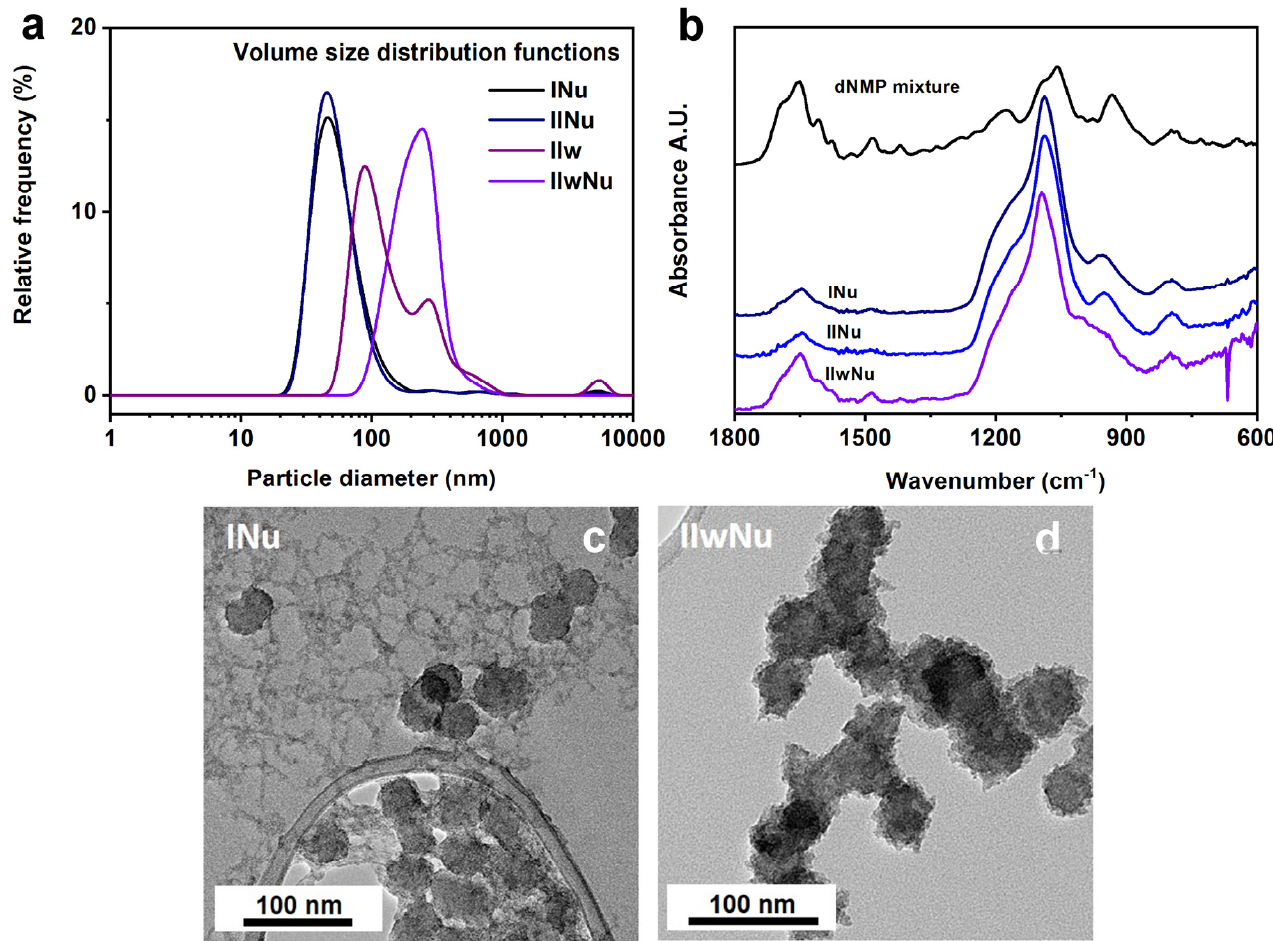
Figure 6. A comparison of samples surface modified in ethanol and in water by ( a ) DLS, ( b ) FTIR spectra and ( c – d ) TEM pictures. The dispersity of the sol is affected by the ethanolic and the aqueous surface modification methods ( a ). A higher surface load can be achieved by surface modification in water ( b ). The addition of aqueous ligand solutions always results in the deposition of zirconia next to the NPs using the ethanolic surface modification method, as shown for dNMP mixture in ( c ) for sample INu , while this is not observed for surface modification after transfer into water ( d ) for sample IIwNu .